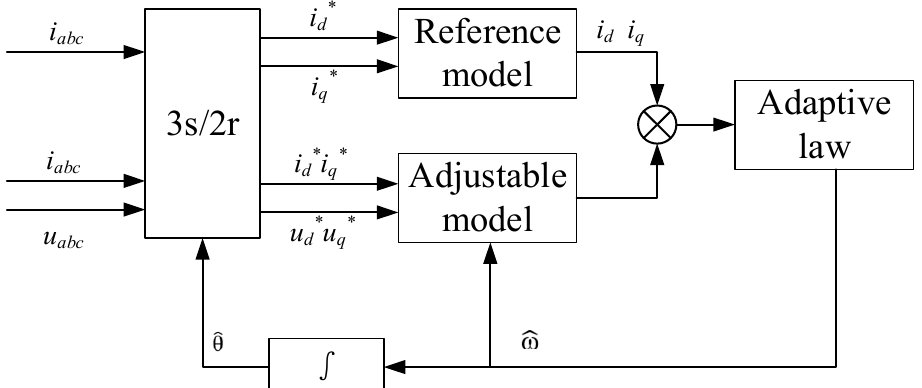
Figure 3. The control structure diagram of MRAS. where the i abc and u abc are obtained from the PMSM. Meanwhile, the current and and voltage in the two-phase rotating coordinate system through the ‘3s/2r’ module.